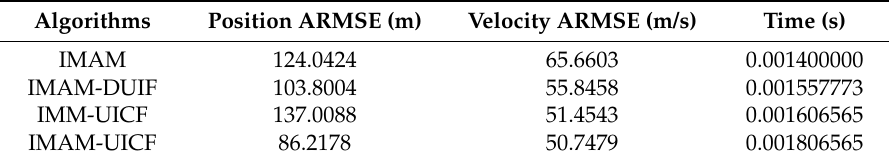
Table 3. Performance comparison of different algorithms.